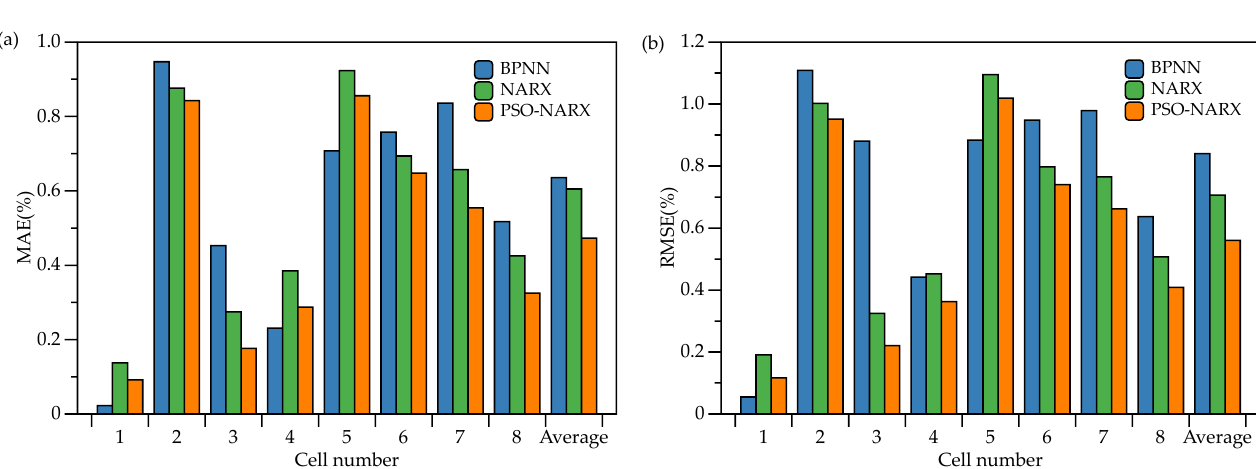
Figure 14. ( a ) MAE of different algorithms; ( b ) RMSE of different algorithms. Table 4. Summary of MAE and RMSE of different algorithms.